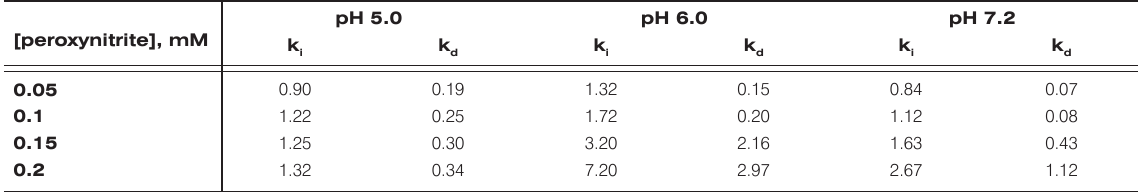
Table 1. The observed first-order rate constants (s -1 ) of quercetin absorbance changes at 550 nm induced by peroxynitrite at different pH as a function of peroxynitrite concentration. [quercetin] = 20 µM. [peroxynitrite],